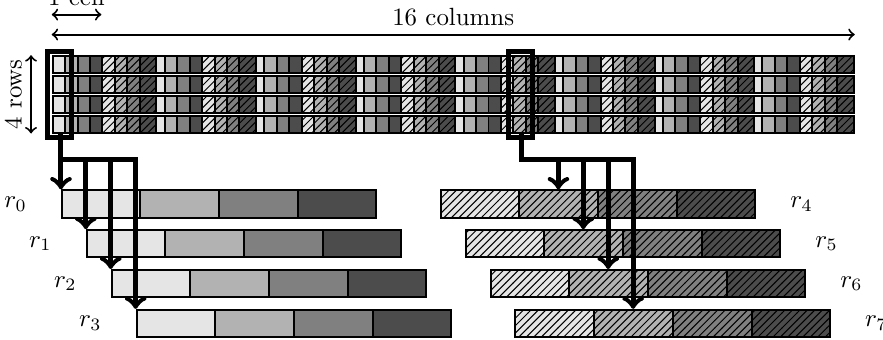
Figure 6: Bitsliced representation for 32-bit architectures. At the top is the 256-bits state, where every rectangle is a bit. At the bottom are 8 32-bit registers labeled r 0 to r 7 , where every colored rectangle is a